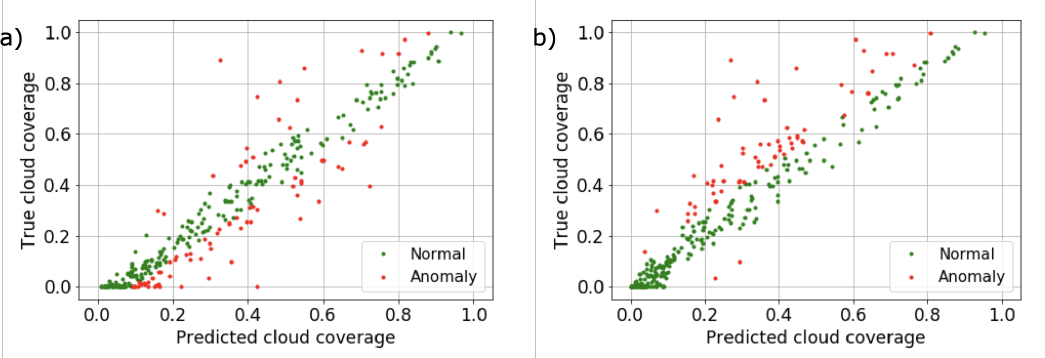
Figure 15. Effect of reflection padding in the first convolutional block on cloud coverage, ( a ) with reflection padding and ( b ) without reflection padding applied on the first block. Reflection padding changes the network characteristics to overestimate cloud coverage, which has a positive effect in performance regarding